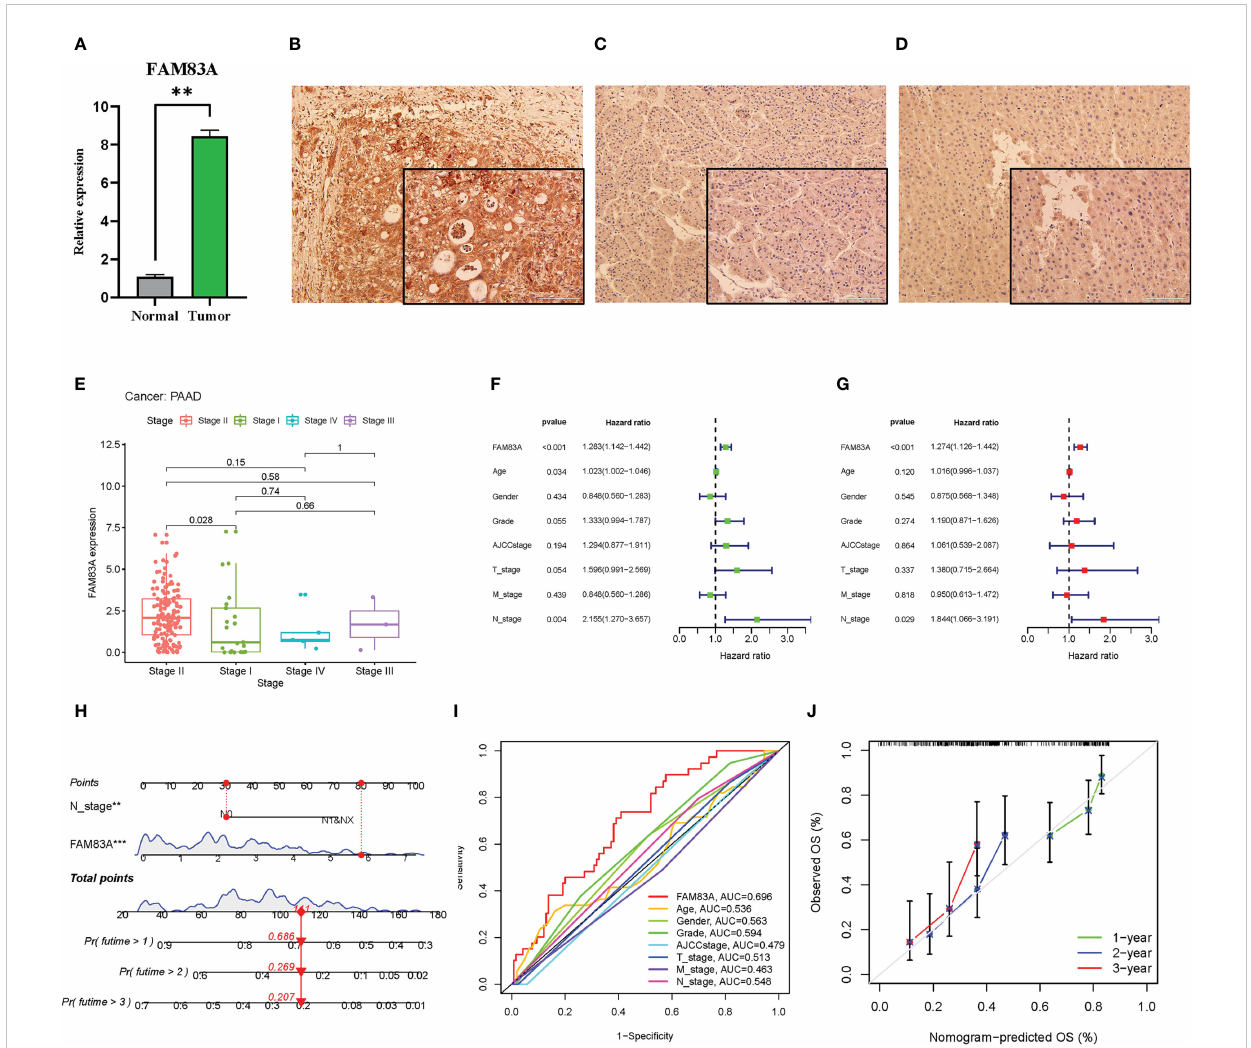
FIGURE 3 The laboratory experiment and clinical signi fi cance of FAM83A in PAAD: (A – D) The laboratory experiment. (A) The qRT-PCR result of FAM83A between the tumor and normal tissues. (B) The Immunohistochemistry (IHC) staining plot in PC. (C) The IHC staining plot in para-cancerous tissue. (D) The IHC staining plot in normal tissue. (E-J) clinical signi fi cance of FAM83A. (E) The correlation analysis of FAM83A with AJCC stage. (F) Univariate Cox regression analysis. (G) Multivariate Cox regression analysis. (H) The nomogram based on FAM83A expression and N stage. (I) The multivariate ROC curves. (J) The calibration curves at 1-, 2-, 3- years. **p value < 0.01; ***p value <